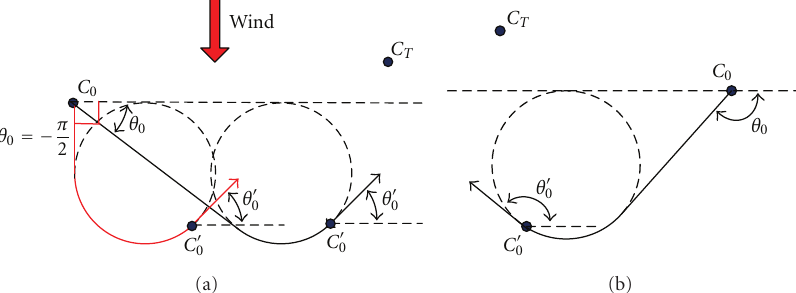
Figure 14: Initial configuration transformation when θ 0 ∈ ( − π ,0) and y T ≥ y 0 . (a) θ 0 ∈ [ − π/ 2,0), red line indicates that θ 0 = − π/ 2 and (b) θ 0 ∈ ( − π , − π/ 2).